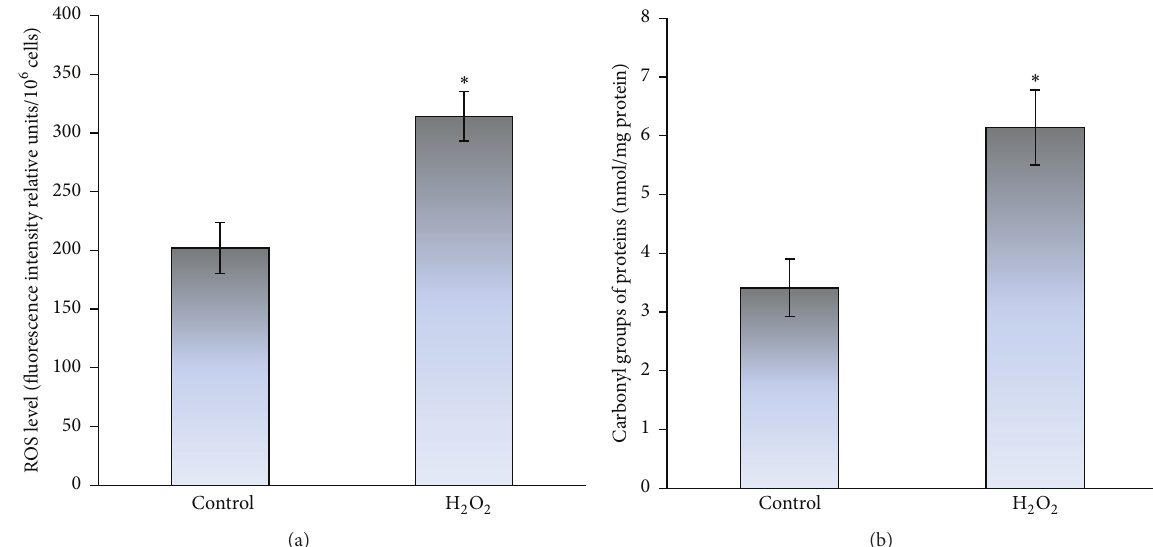
Figure 2: Effect of hydrogen peroxide on the level of oxidative stress markers: ROS (a) and protein carbonyls (b), in S. cerevisiae YPH250. Results are shown as the mean ± SEM ( 𝑛 = 3 – 7 ). ∗ Significantly different from respective values for control cells (without H 2 O 2 ) with 𝑃 < 0.05 .